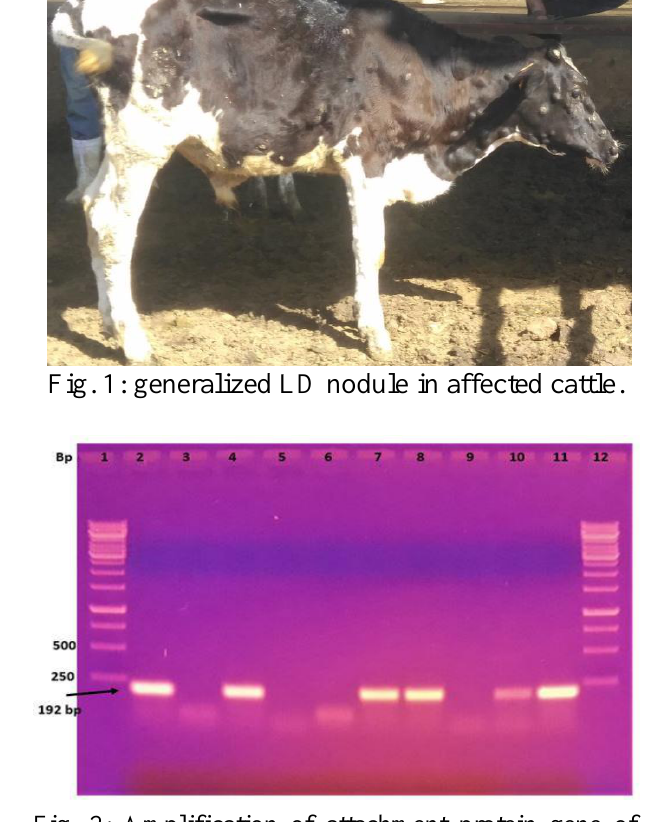
Fig. 2: Amplification of attachment protein gene of LSD showing fragment length of 192bp, lane (1) 1 Kb DNA ladder, lane (2) positive control, lane (4, 7, 8 10 and 11) samples collected from clinically infected cattle, lane (3, 5, 7 and 9) negative control samples. Table 1: Sensitivity and specificity of VNT using SPV and LSDV compared to ELISA Kit